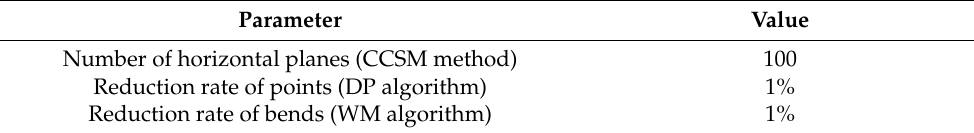
Table 1. Experimental parameter settings of three simplification methods for generating 100 simpli- fied